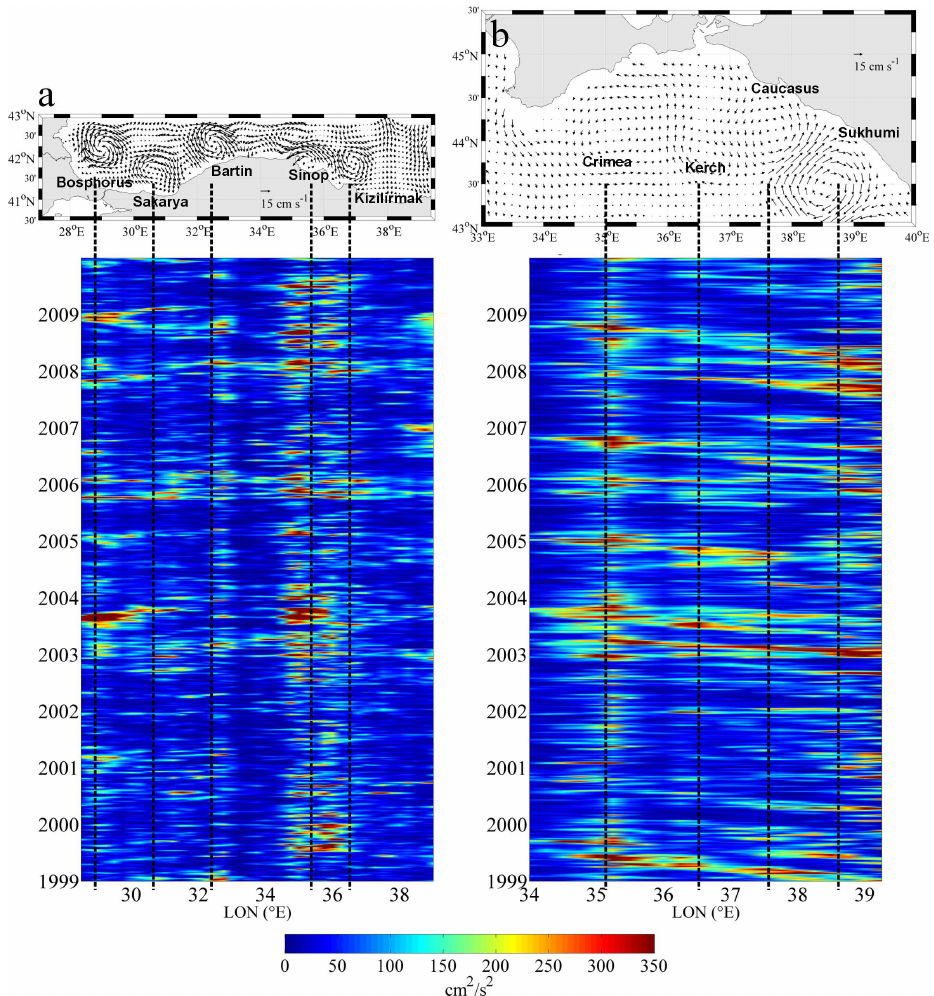
Fig. 5. Hovmoller diagrams of KE over the (a) Anatolia and (b) Crimea–Caucasus coasts. In the upper panels daily snapshots of the anomalies of surface geostrophic velocities (3 May 2001 and 15 January 1999, respectively) indicate the location of the main eddies along the BS coasts; these anomalies are depicted with the original spatial resolution of AVISO products (of one-eighth of a degree) in order to better discriminate the mesoscale structures. Dashed lines mark the locations of mesoscale